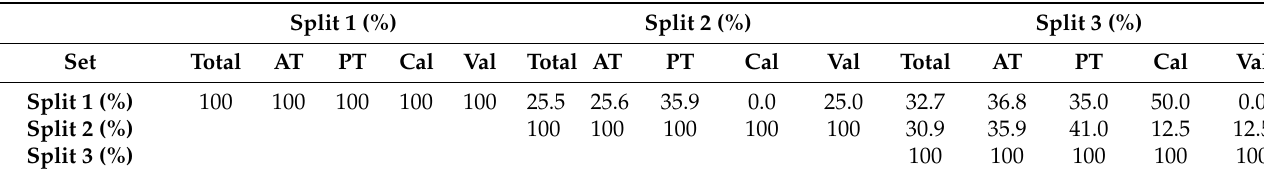
Table 9. Percentage of the identity of the three splits.